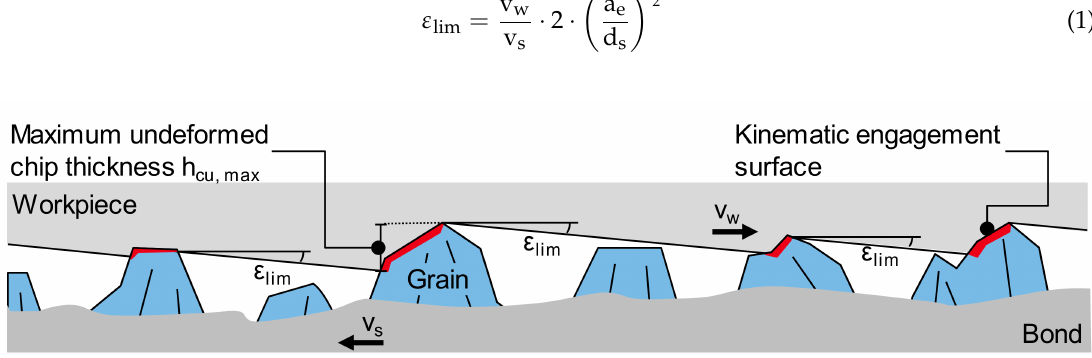
Figure 3. Approach for calculating the kinematic engagement surfaces on the